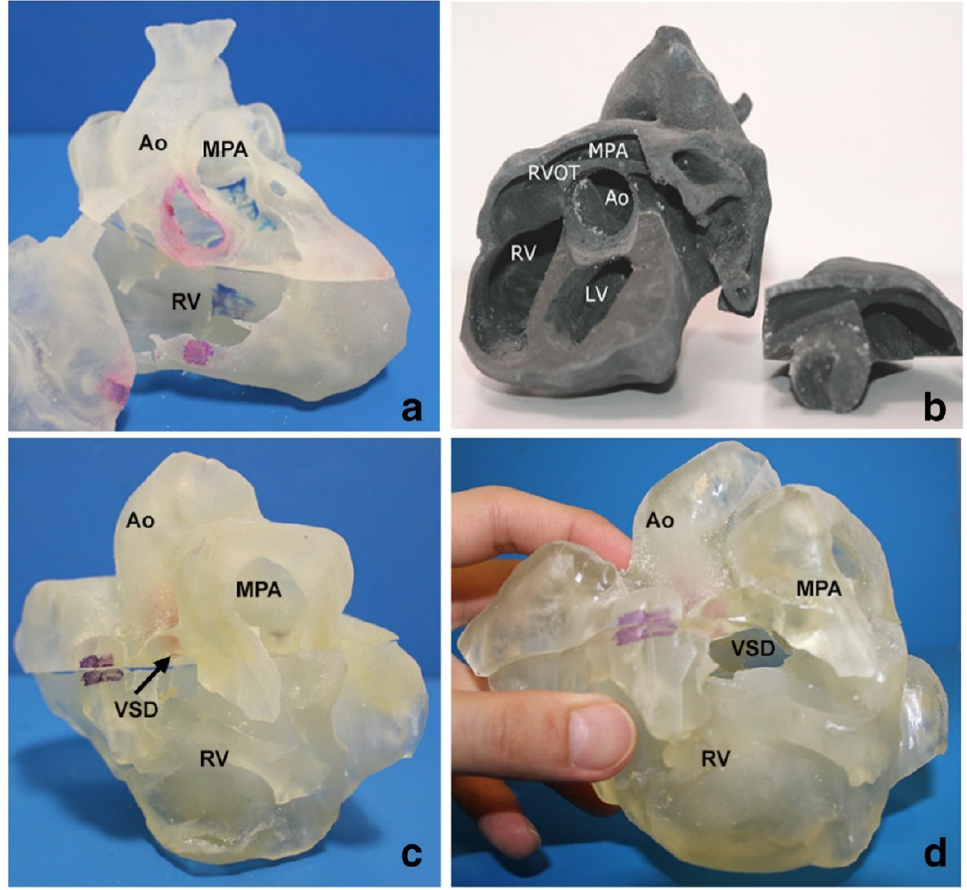
Figure 1. 3D printed heart models showing normal anatomy and pathology. ( a ) Normal heart model created from cardiac CT and is partitioned into three pieces allowing visualization of interventricular septum. ( b ) Repaired tetralogy of Fallot (ToF) from an adult patient. The model was created from cardiac magnetic resonance imaging (MRI) and separated into two pieces allowing for clear visualization of overriding aorta and pulmonary infundibular stenosis. ( c ) Unrepaired ToF heart model from an infant. The model was created from 3D echocardiographic images and partitioned into two pieces showing the ventricular septal defect (VSD). ( d ) Unrepaired ToF heart model from an infant with superior and inferior portions showing VSD and the aortic overriding in relation to the VSD. Reprinted with permission under the open access from Loke et al. [20].